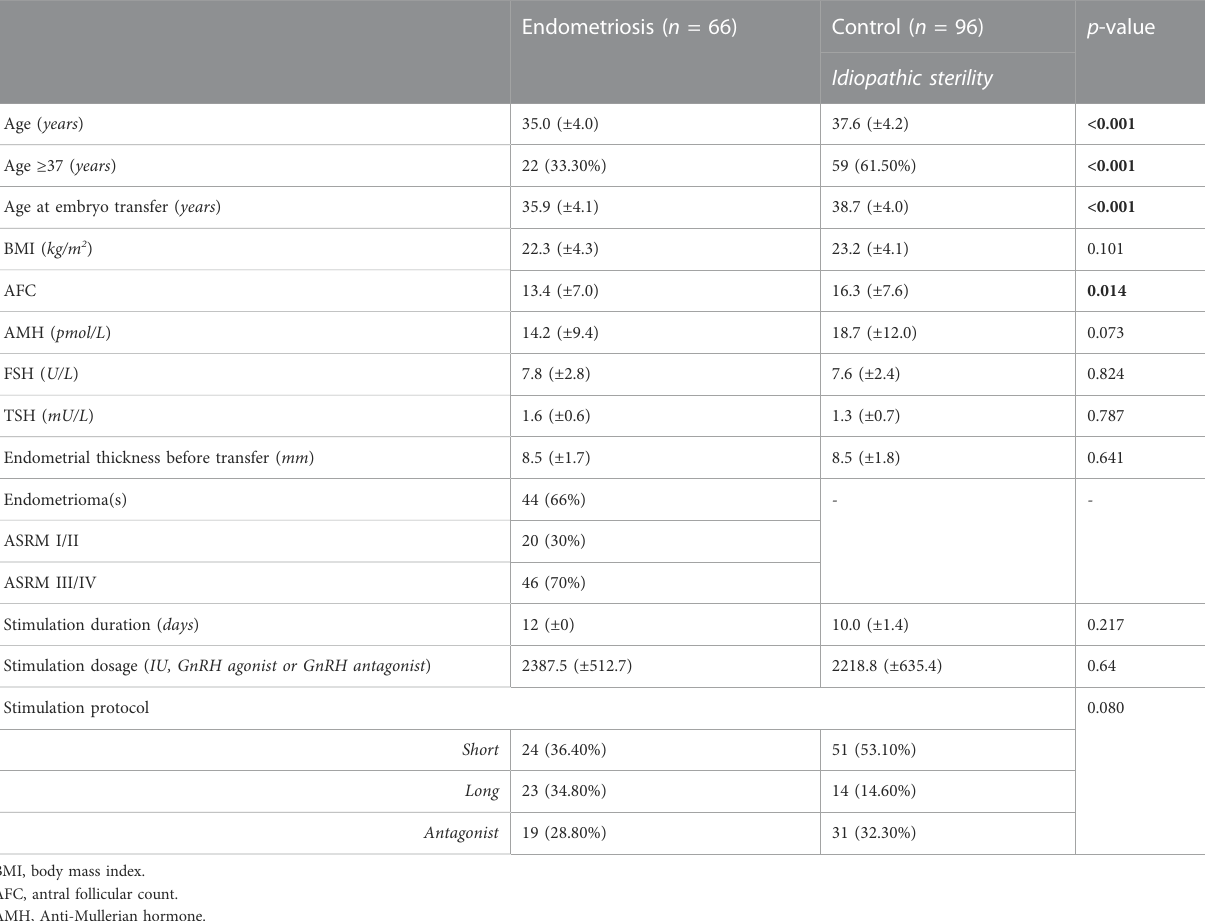
TABLE 1 Patient and treatment cycle characteristics.